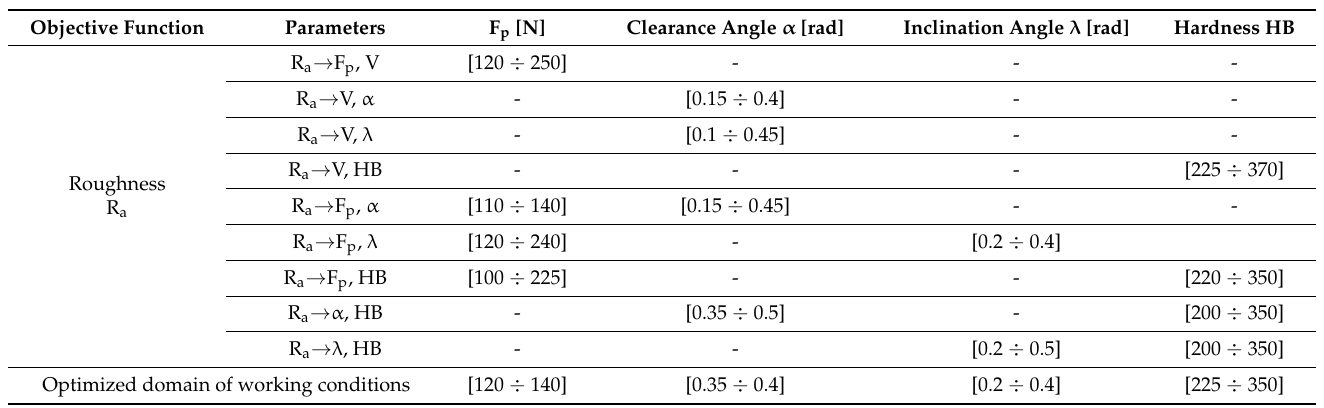
Table 3. Optimized intervals of parameters.